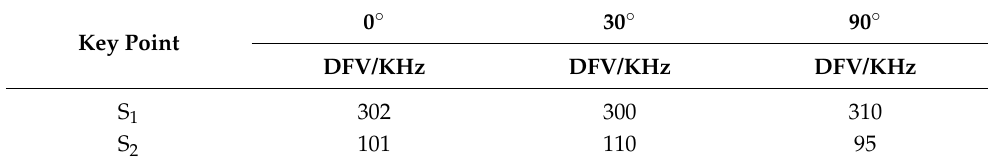
Table 6. Dominant frequency value of key point for different bedding angles under saturated state.